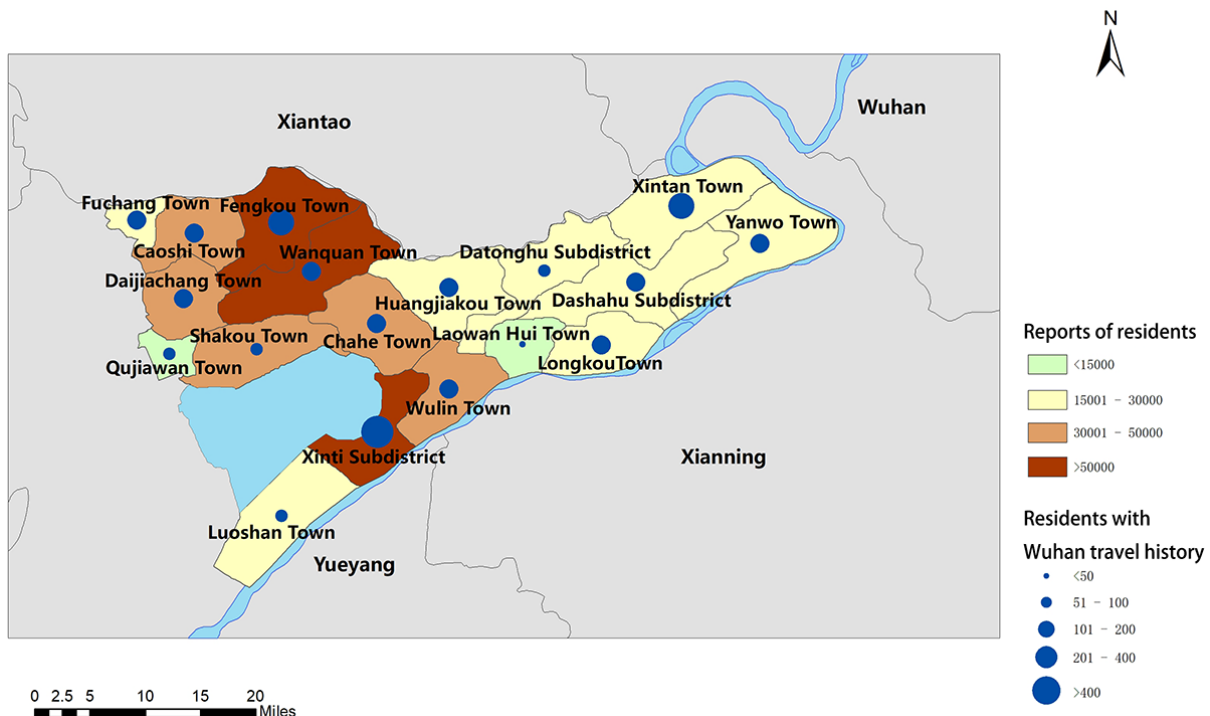
Figure 2. Honghu health reports heat